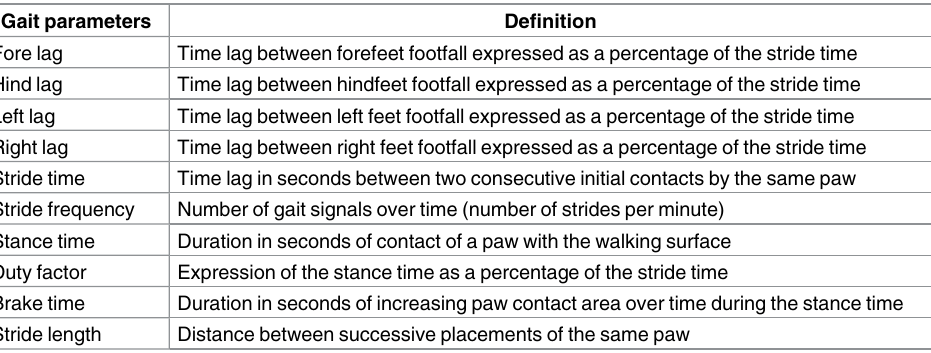
Table 2. Definition of gait parameters.